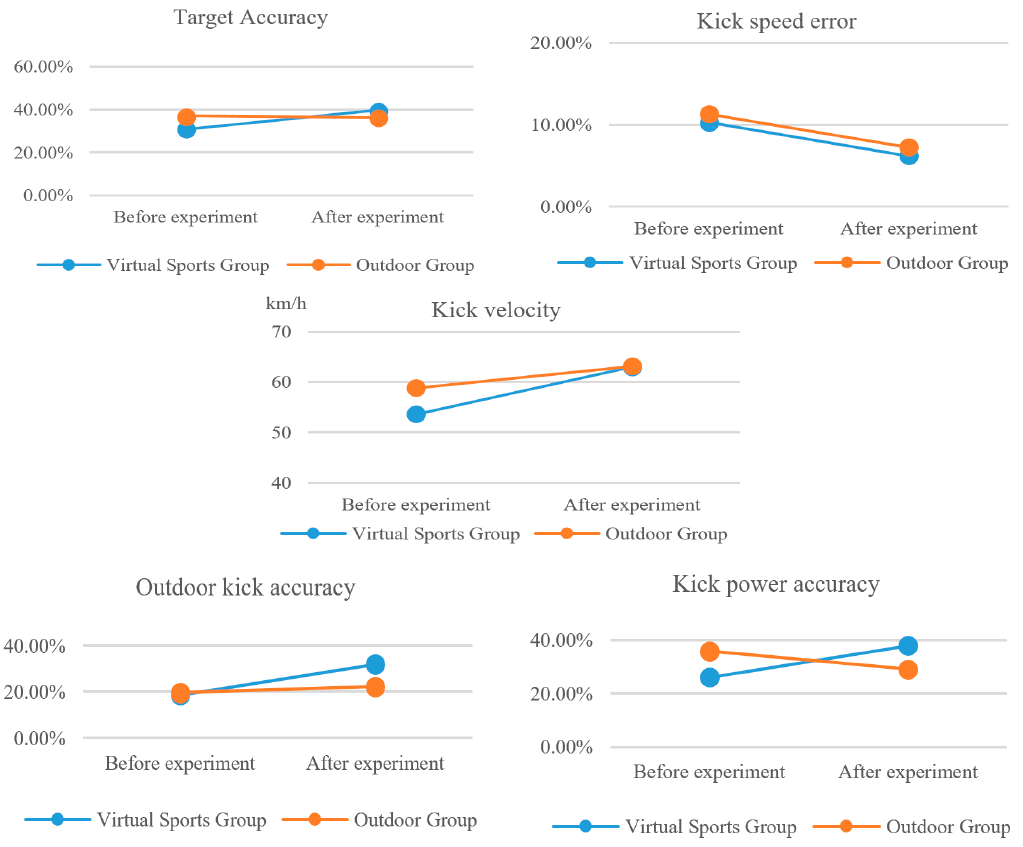
Figure 14. Comparison of training results between the virtual sport and the outdoor group.